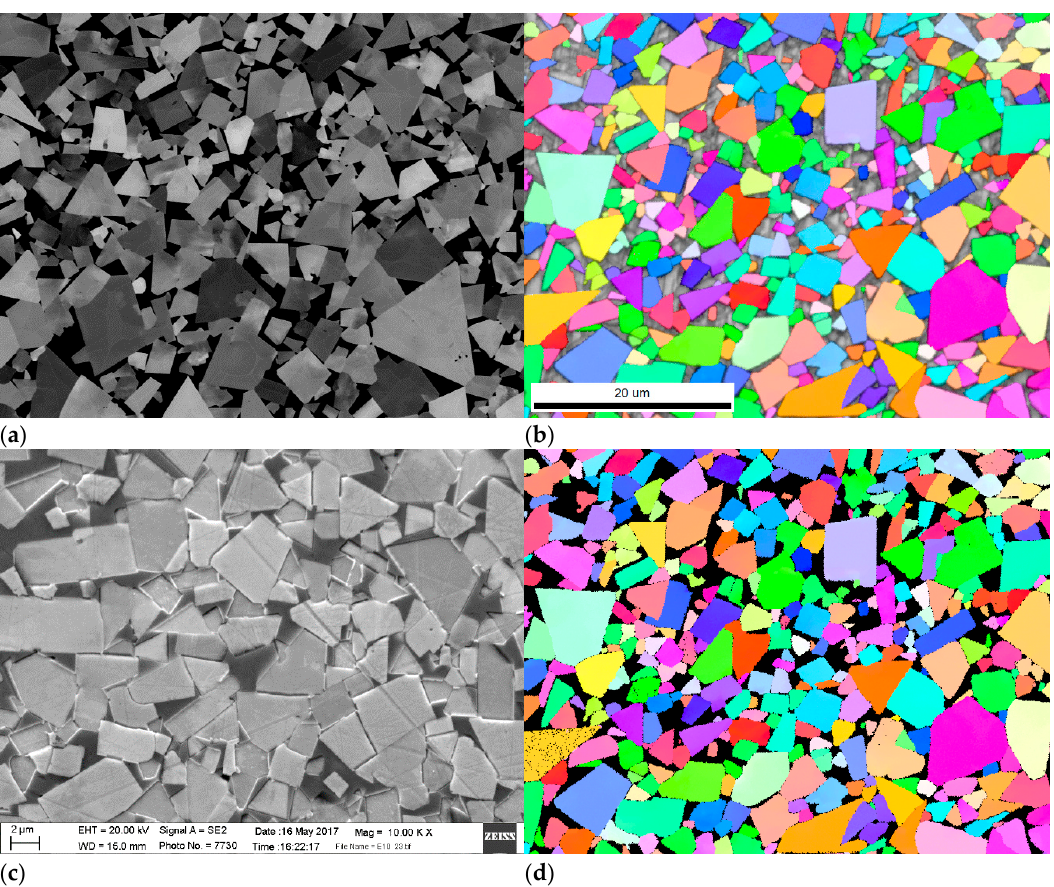
Figure 2. Examples of the images from Sample 10M distributed for the interlab measurement ( a ) backscattered electron image, ( b ) WC shown with Inverse Pole Figure (IPF) orientation colour scale superimposed on grey scale EBSD pattern quality map, referred to as EBSD 1 in subsequent figures, ( c ) secondary electron image of etched sample (note slightly higher magnification than other images), ( d ) Figure 2b shown with binder in black (EBSD on black)—EBSD2 in subsequent figures.